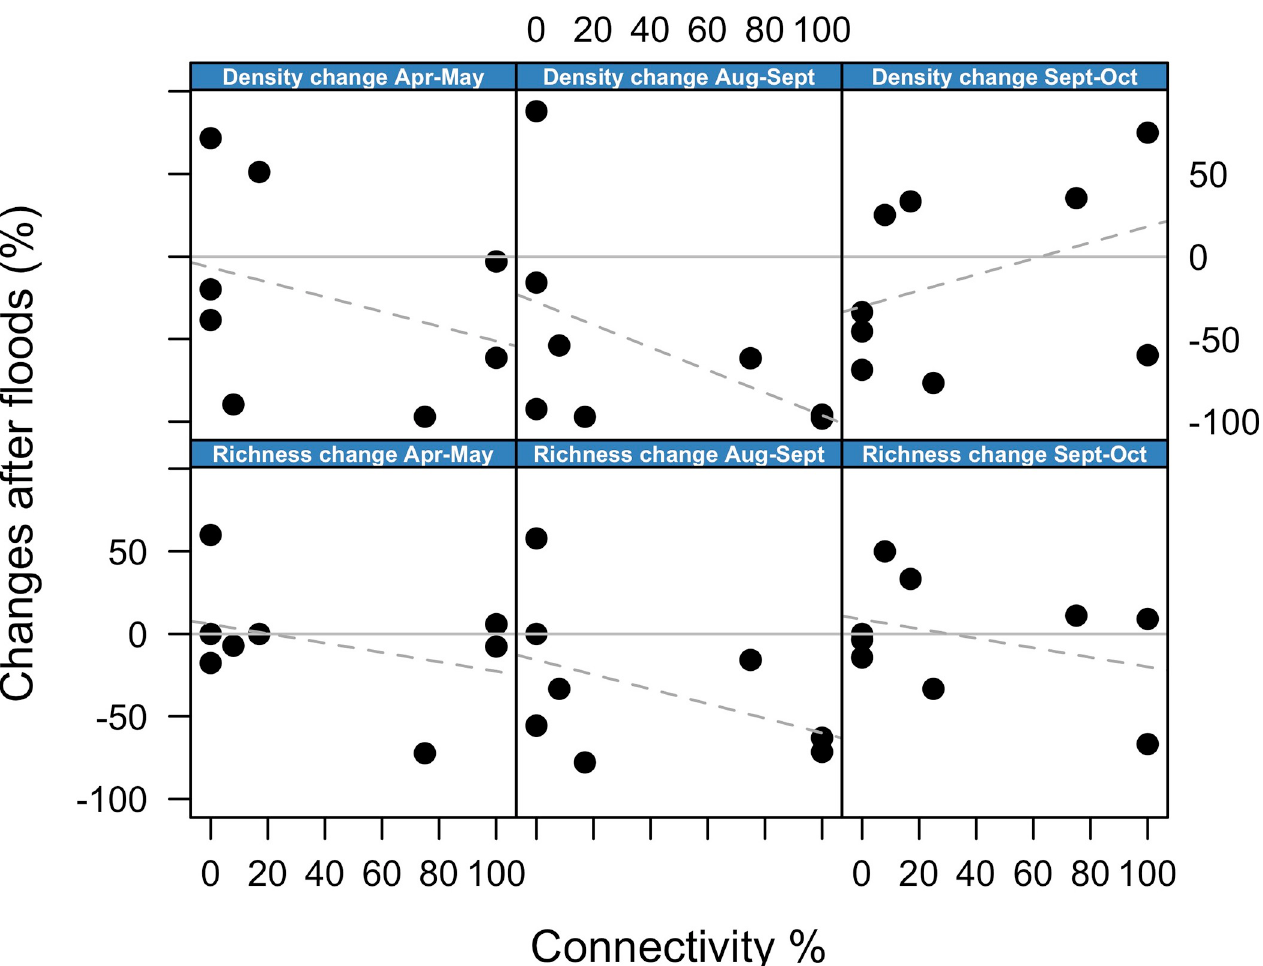
Fig 5. Change in community metrics after floods. Relationship between hydrologic connectivity and percentage changes in density and richness after each flooding event. Each panel shows changes in either density or richness between consecutive months during which flooding occurred (e.g. April-May). Zero change is indicated by a solid grey horizontal line. No significant correlations were observed. For visualisation purposes, a dashed grey line indicates the direction of the relationship.